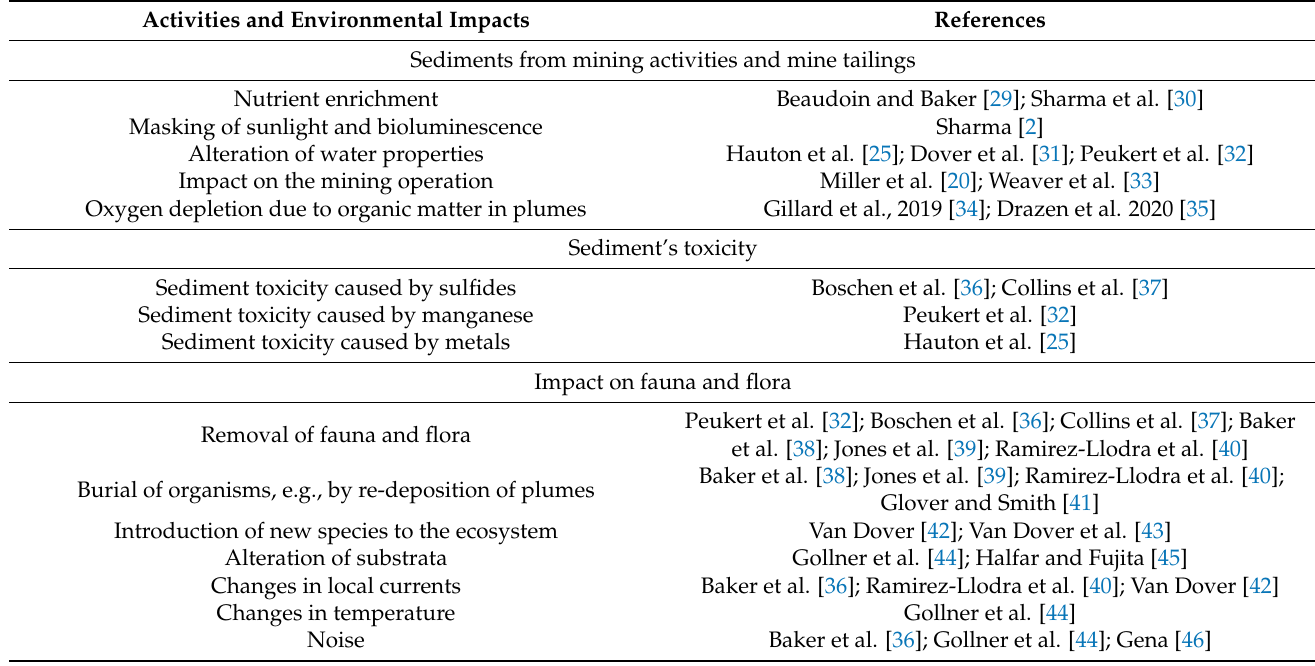
Table 2. Major risk-prone DSM activities and their potential impacts on the